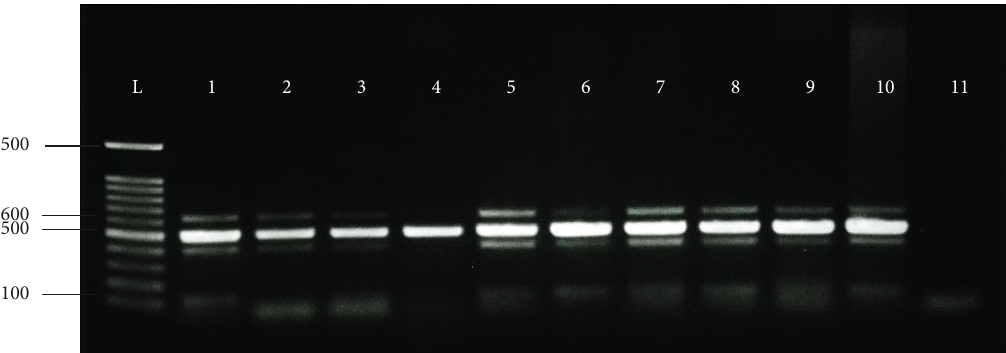
Figure 1: Detection of FLT3 ITDs in MCT-bearing dogs. FLT3 PCR products, obtained using the primers spanning exons 14 and 15, were analysed by agarose gel electrophoresis. A single band of 500bp was obtained in FLT3-wild type MCT cases (lanes 3, 4, and 6), while an extra-band above 500bp was shown in mutated samples (lanes 1, 2, 5, 7, 8, 9, and 10). Lane 1 - DNA ladder (100bp); Lane 11 - negative PCR control (water).